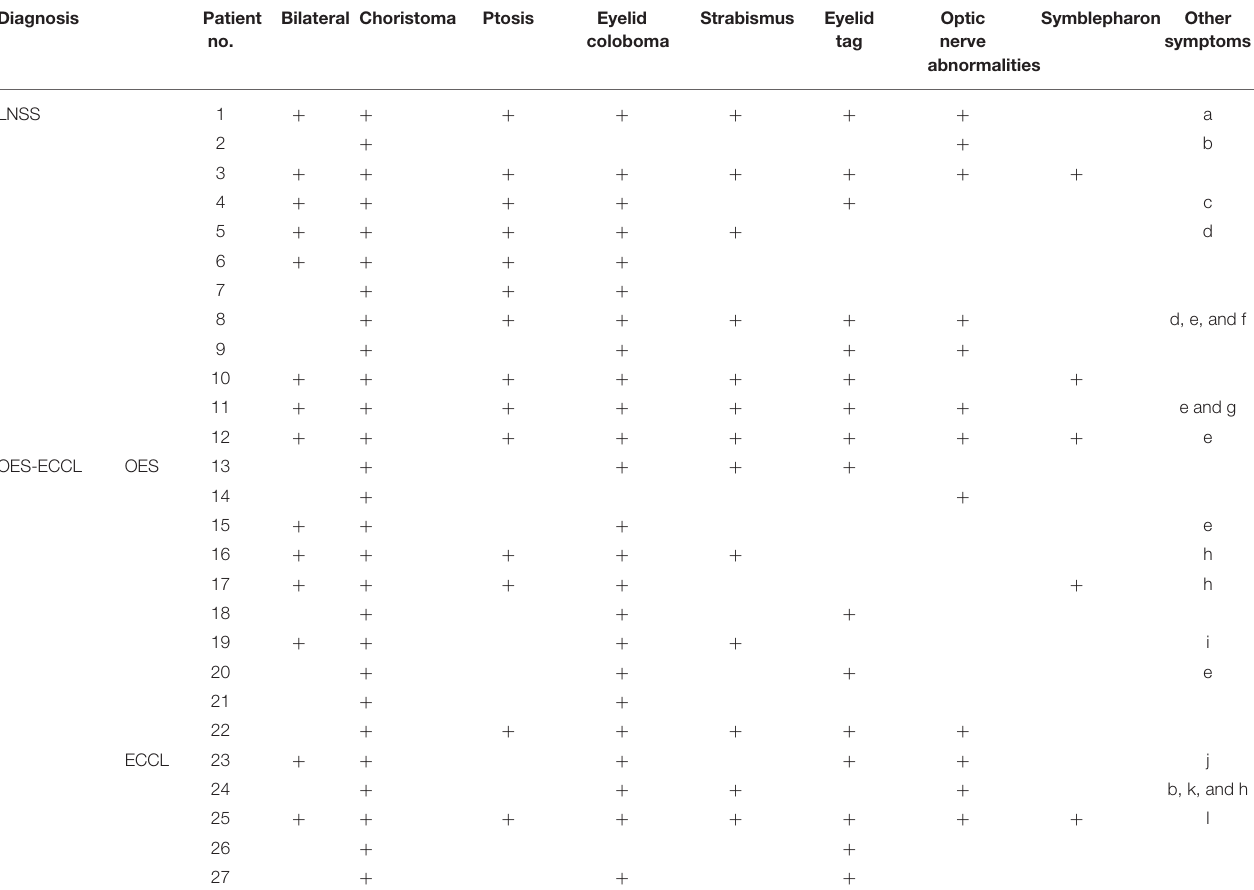
TABLE 2 | Ocular manifestations of patients with LNSS and OES-ECCL. Diagnosis